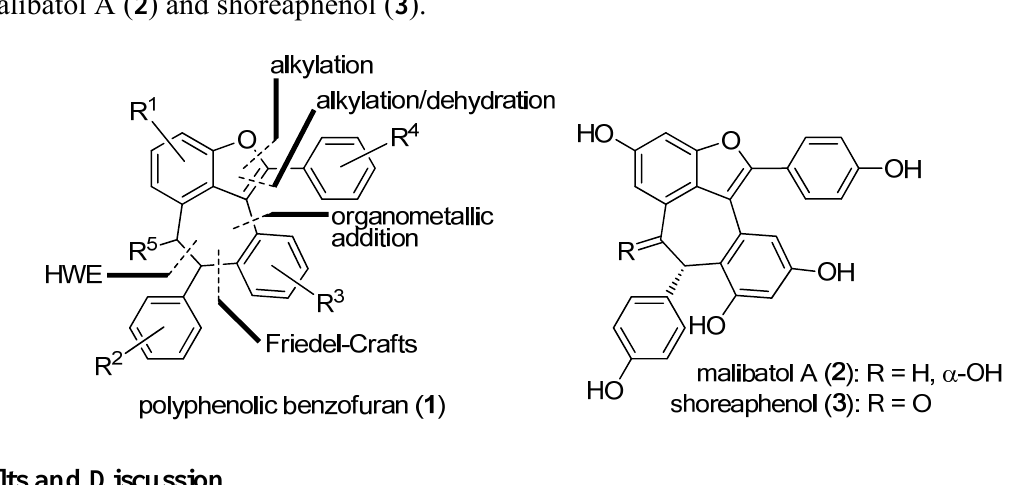
Figure 1. Generic molecular structure of polyphenolic benzofuran 1 and structures of malibatol A ( 2 ) and shoreaphenol ( 3